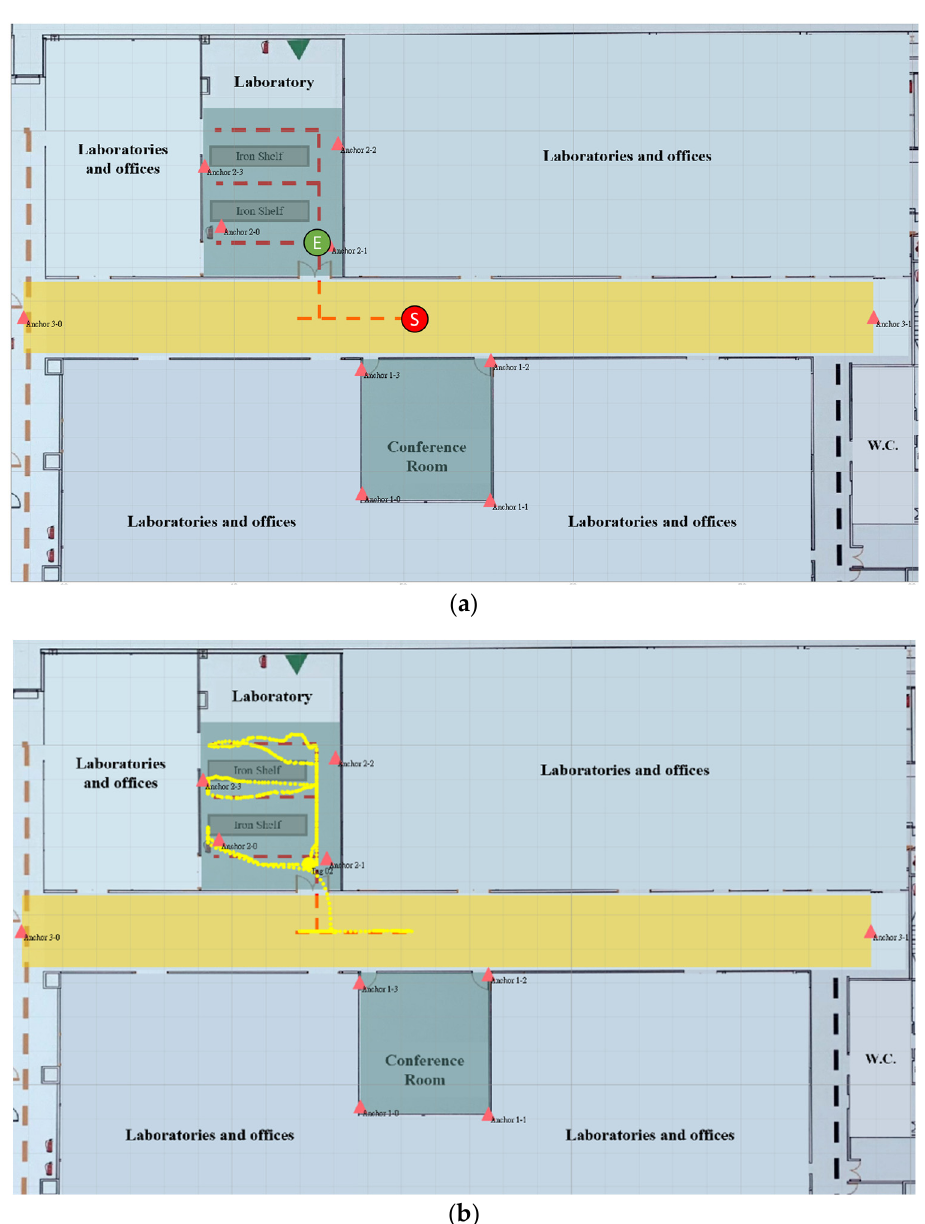
Figure 24. ( a ) Real trace and ( b ) estimated trace of tag 2.